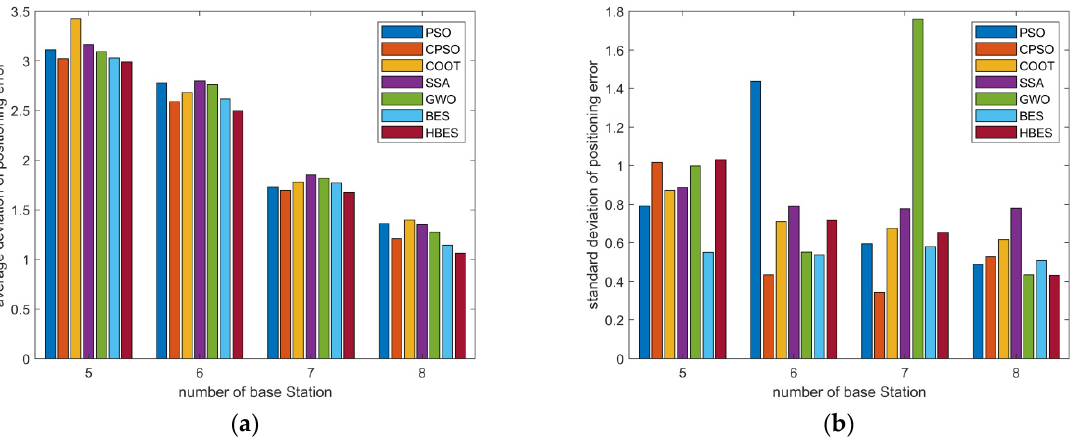
Figure 9. Error statistics of base stations in 3D scenes. ( a ) The average error of the algorithm in the experiment in different base stations; ( b ) the standard deviation of the algorithm in the experiment in different base stations.